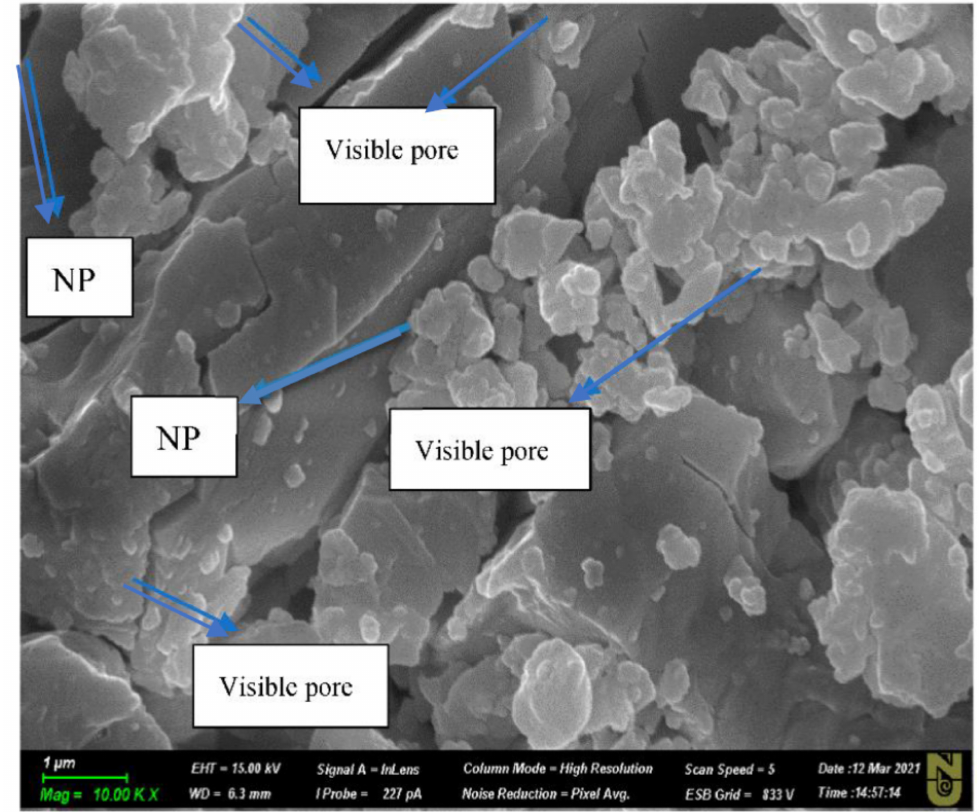
Figure 23. Image of a core sample after the flood test.